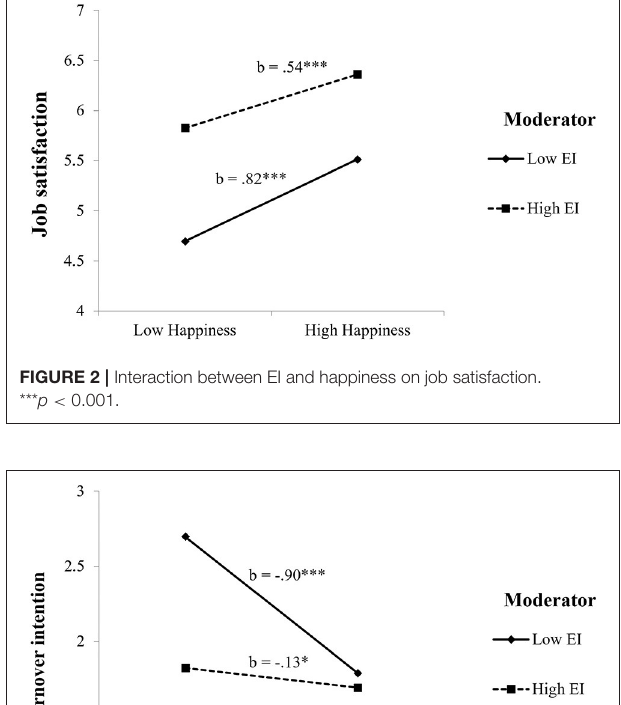
significant. The percentages of variance explained were 41% for job satisfaction and 7% for turnover